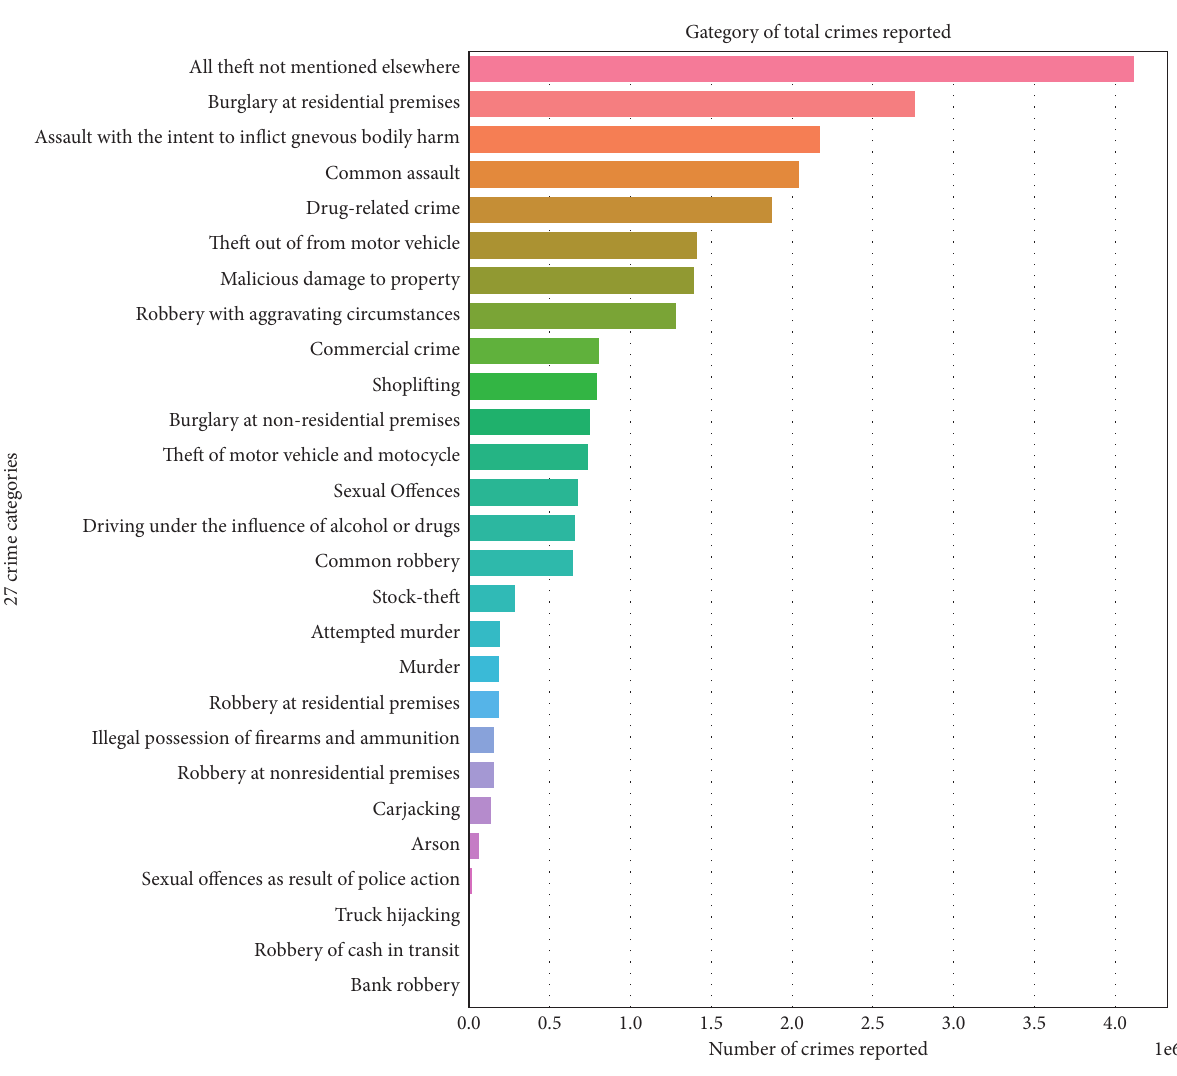
Figure 4: Crime category reported in South African provinces